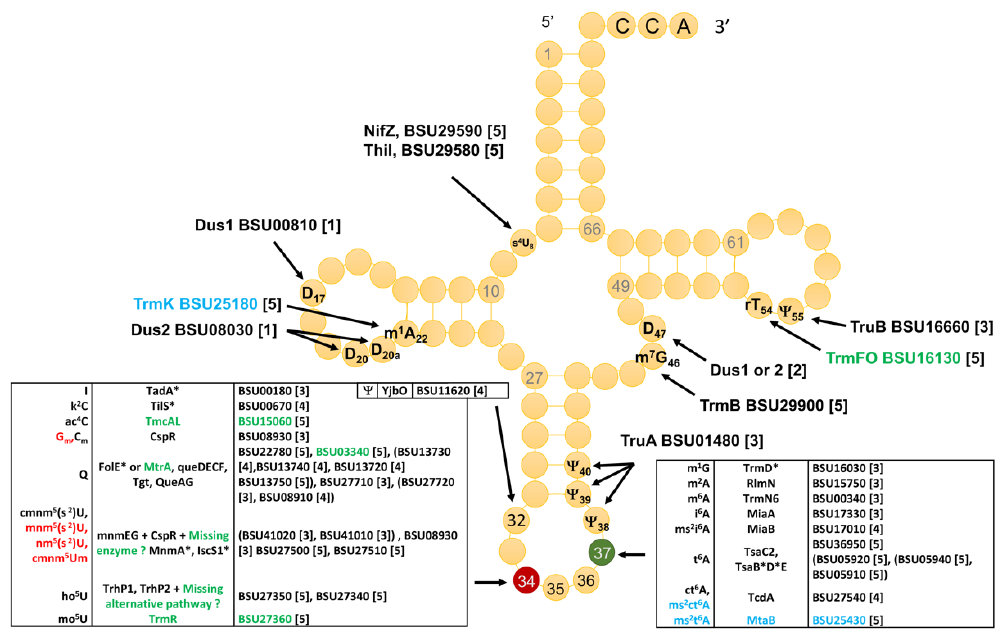
Figure 3. B. subtilis tRNA modifications with predicted and validated corresponding enzymes. The four modifications in red were found in the current analysis but were not present in the B. subtilis tRNA sequences listed in Modomics. Proteins with stars (*) are encoded by essential genes in B. subtilis . Proteins in green are non ‐ orthologous to the enzyme catalyzing the same reaction in E. coli . Proteins in blue insert modifications that are not found in E. coli . The confidence score for the prediction is as follows: (5), validated in vitro with the B. subtilis enzymes and in vivo with the B. subtilis deletion mutant; (4), orthologous to a validated enzyme in other species, genetic data in B. subtilis ; (3), orthologous to a validated enzyme in other species, with mapping data in B. subtilis ; (2), orthologous to a validated enzyme in other species, without mapping data in B. subtilis ; (1), similarity with experimentally enzyme validated in other species but paralogs.